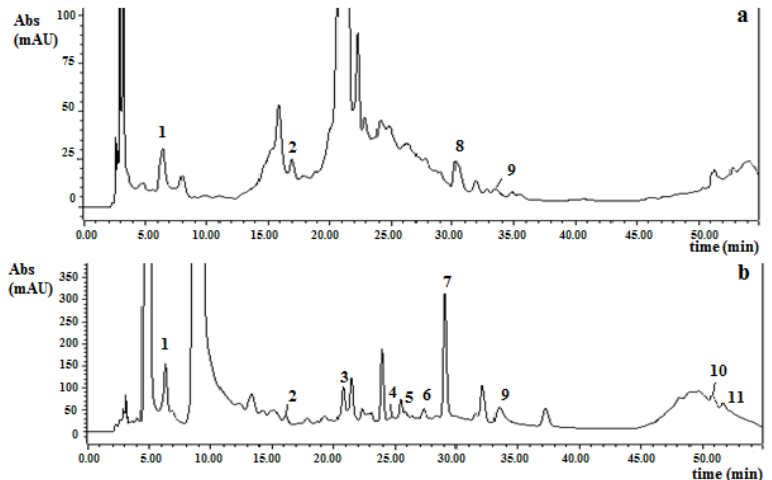
Figure 1. HPLC-DAD chromatograms of a Camarosa strawberry extract before ( a ) and after ( b ) acid hydrolysis (4 mol/L HCl, 50 min at 90 °C) at 280 nm. Peak identification: 1, gallic acid; 2, (±)-catechin; 3, (−)-epicatechin; 4, ferulic acid; 5, p -coumaric acid; 6, cyanidin; 7, pelargonidin; 8, rutin; 9, ellagic acid; 10, quercetin; 11, kaempferol.